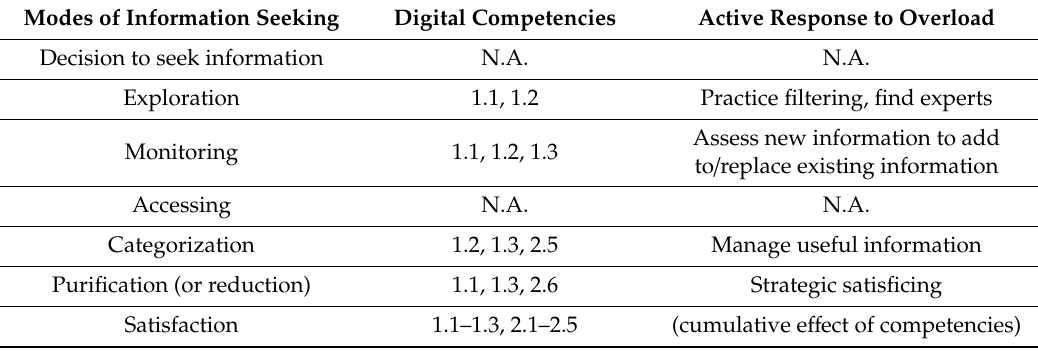
Table 2. Modes of information seeking related to digital